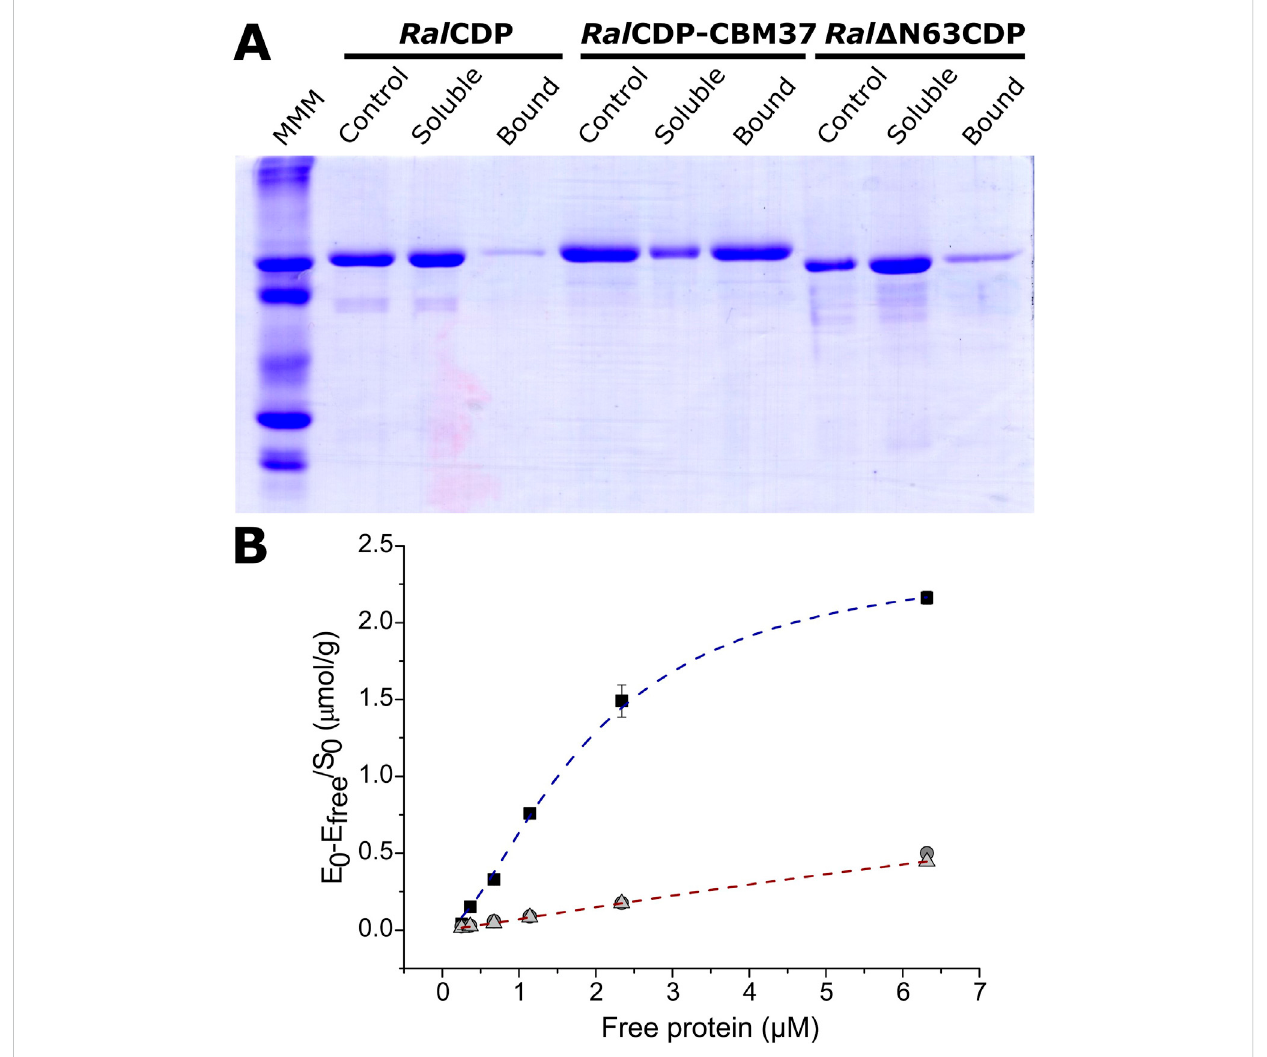
FIGURE 6 Analysis of CDP variants binding capacity to PASC. SDS-PAGE of the different fractions after incubation with the substrate (Control: enzyme incubated without substrate) (A) . Binding isotherms for Ral CDP (circles), Ral CDP-CBM37 (squares), and Ral Δ N63CDP (triangles) (B)